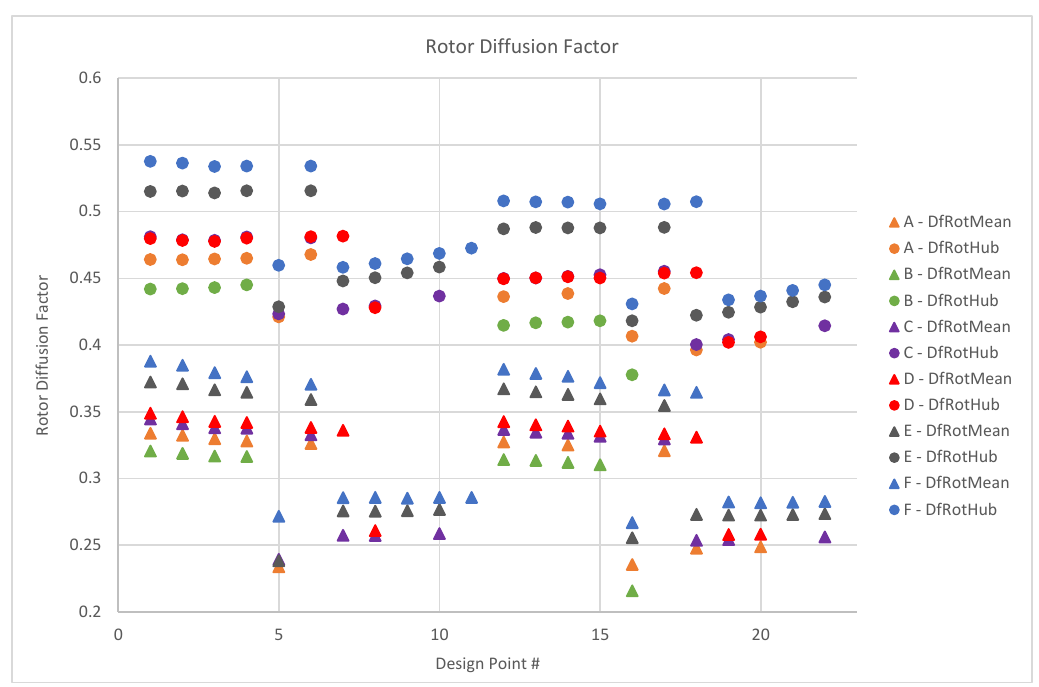
Figure 20. Variations in the rotor diffusion factor with the different rotor blade parameters.